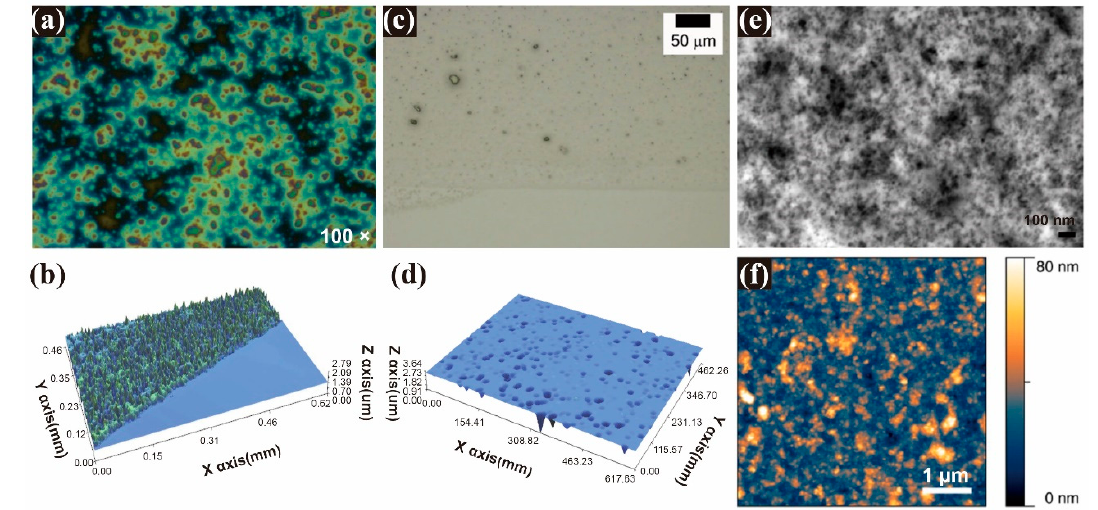
Figure 9. ( a ) Microscopy image at 100× resolution and ( b ) surface profile of the sensing layer (PEDOT:PSS-PVA) [76]; ( c ) microscopy image and ( d ) surface profile of the sensing layer (PEDOT:PSS-ZnSnO 3 ) [75]; ( e ) STEM micrograph and ( f ) atomic force microscopy scan of the sensing layer (PEDOT:PSS-Fe 3 O 4 / γ -Fe 2 O 3 ) [69].